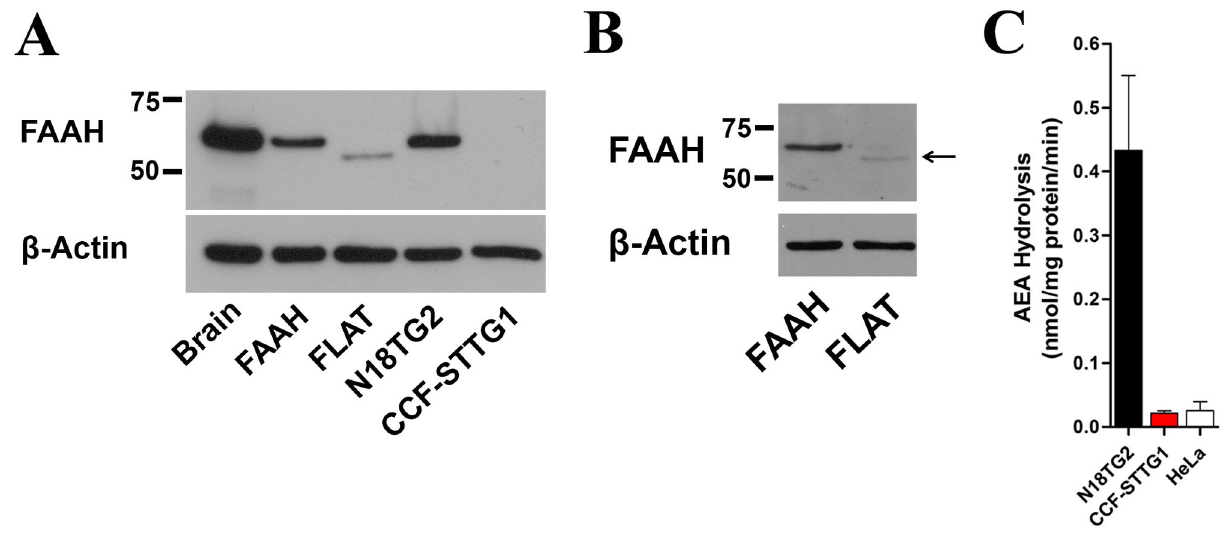
Figure 2. Expression of FAAH and FLAT in cell-lines. (A) Western blot of FAAH and FLAT expression in brain, HeLa cells transfected with FAAH (0.15 µg) or FLAT (1.5 µg), and in N18TG2 neuroblastoma and CCF-STTG1 astrocytoma cells. (B) Expression of FAAH and FLAT following transfection into HEK-293 cells. (C) AEA hydrolysis in homogenates of N18TG2, CCF- STTG1, and HeLa cells (n = 3).